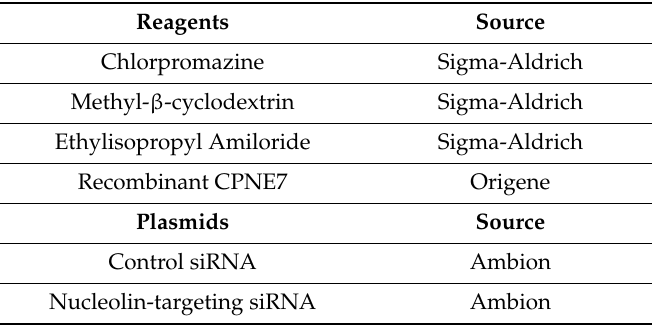
Table 3. List of reagents and plasmids